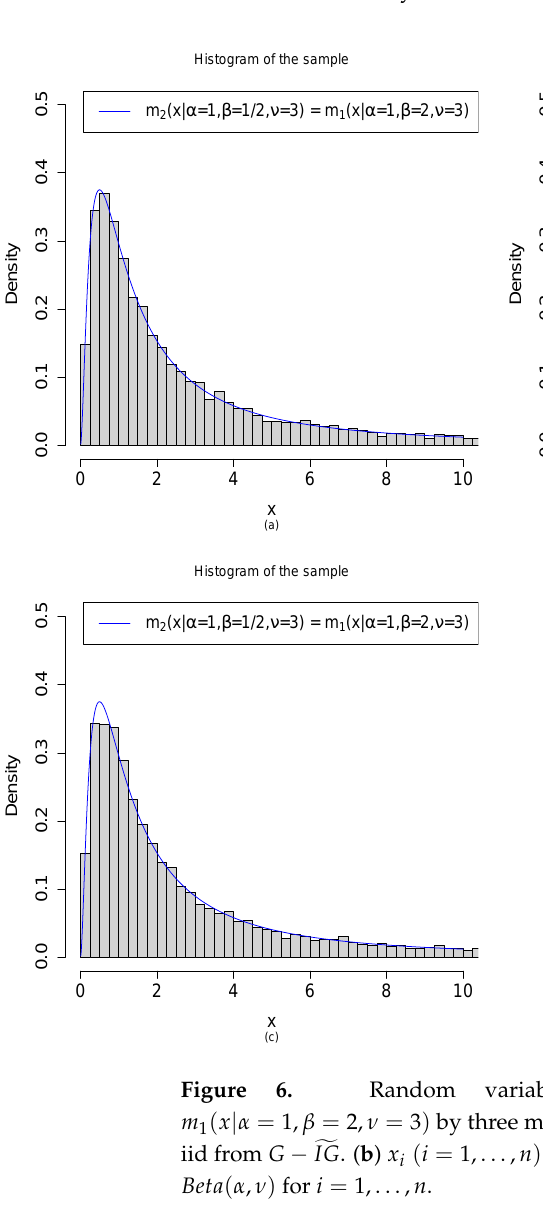
Figure 6. Random variable generations from m 2 ( x | α = 1, β = 1/2, ν = 3 ) = m 1 ( x | α = 1, β = 2, ν = 3 ) by three methods with α = 1, β = 1/2, and ν = 3. ( a ) x i ( i = 1, . . . , n ) are iid from G − (cid:102) IG . ( b ) x i ( i = 1, . . . , n ) are iid from (cid:101) G − (cid:101) G . ( c ) x i = ( 1/ y i − 1 ) β , where y i are iid from Beta ( α , ν ) for i = 1, . . . , n